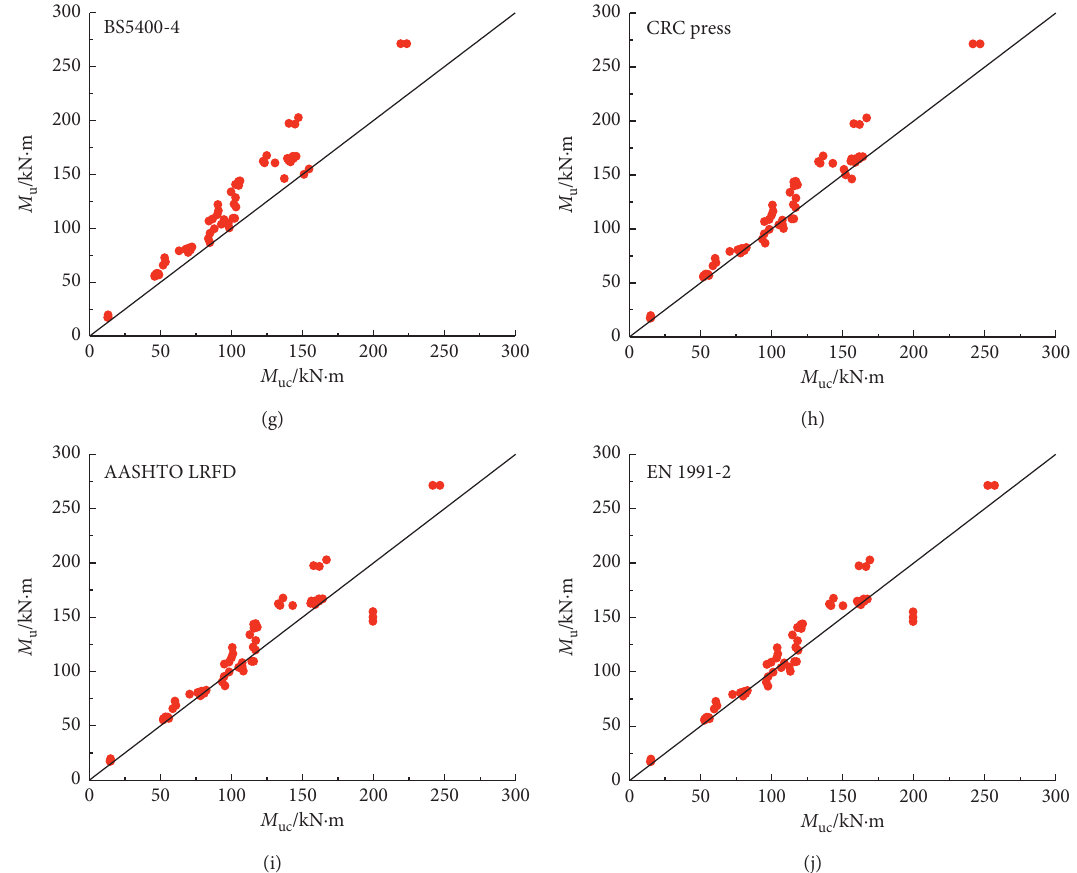
Figure 7: Comparison of experimental flexural bearing capacity M